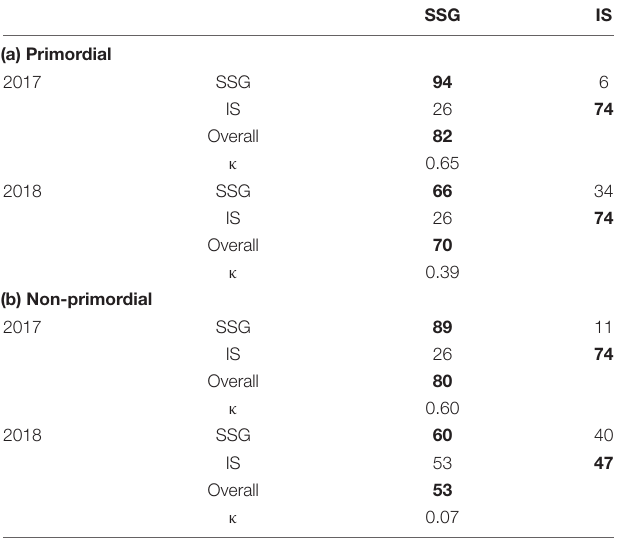
TABLE 3 | Classification success for the spatial comparison of multi-elemental chemistry for the (a) primordial and (b) non-primordial areas of larval King George whiting otoliths in 2017 and 2018.